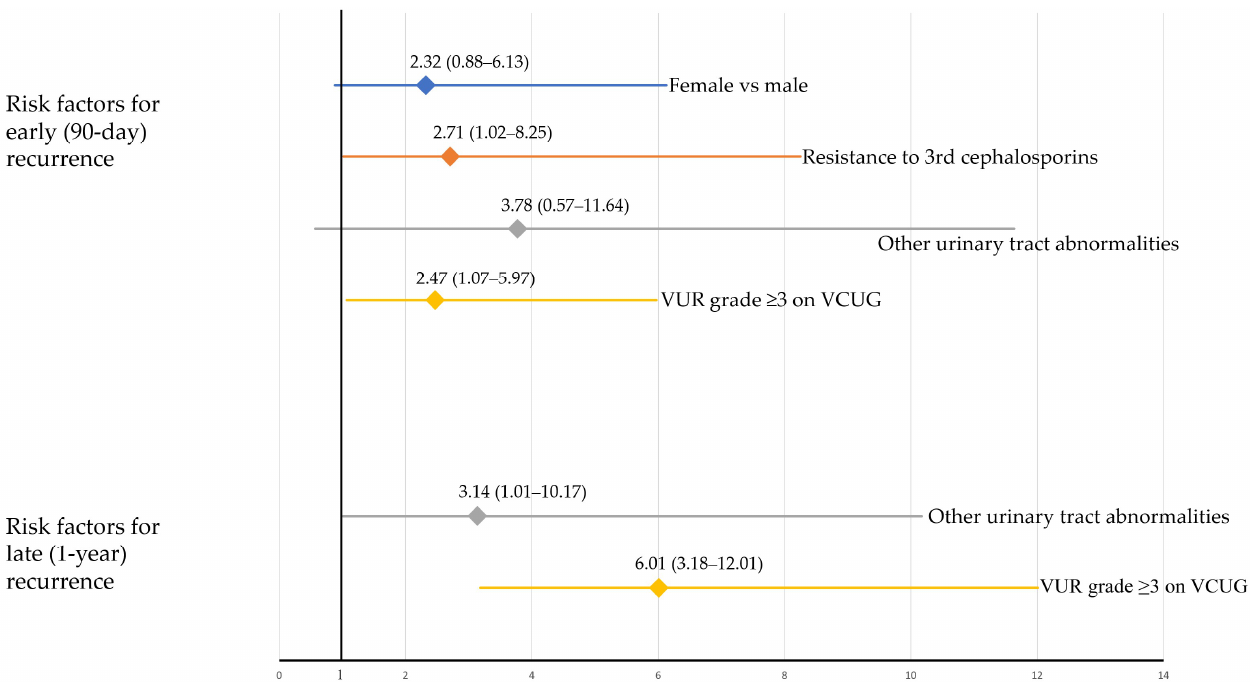
Figure 2. Bootstrap-adjusted odds ratios of various risk factors for early (90-day) and late (1-year) recurrence.